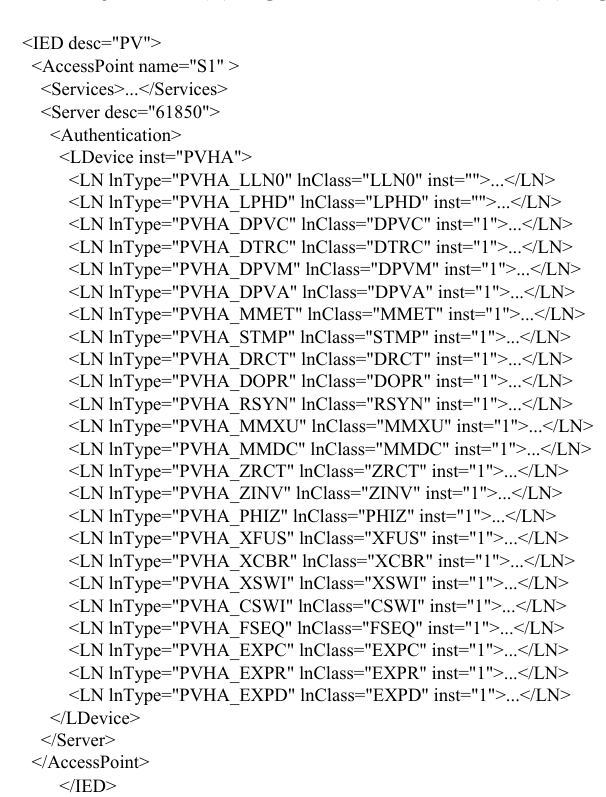
Figure A1. Data objects of ( a ) AgentPerformative and ( b ) AgentContent.